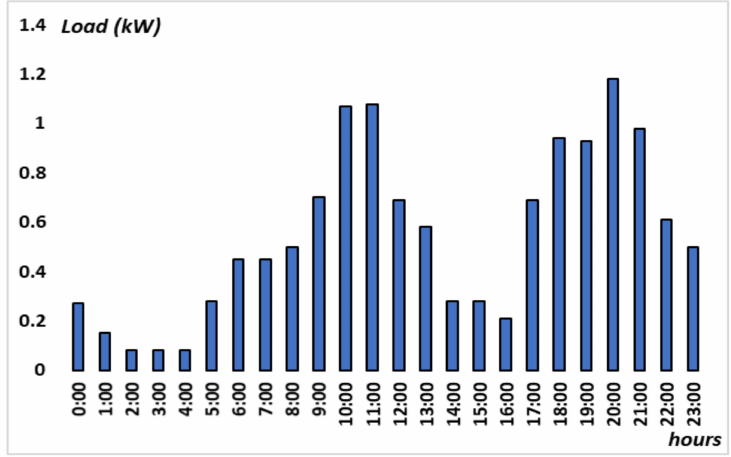
Figure 5. Typical daily electricity demand profile of the household in